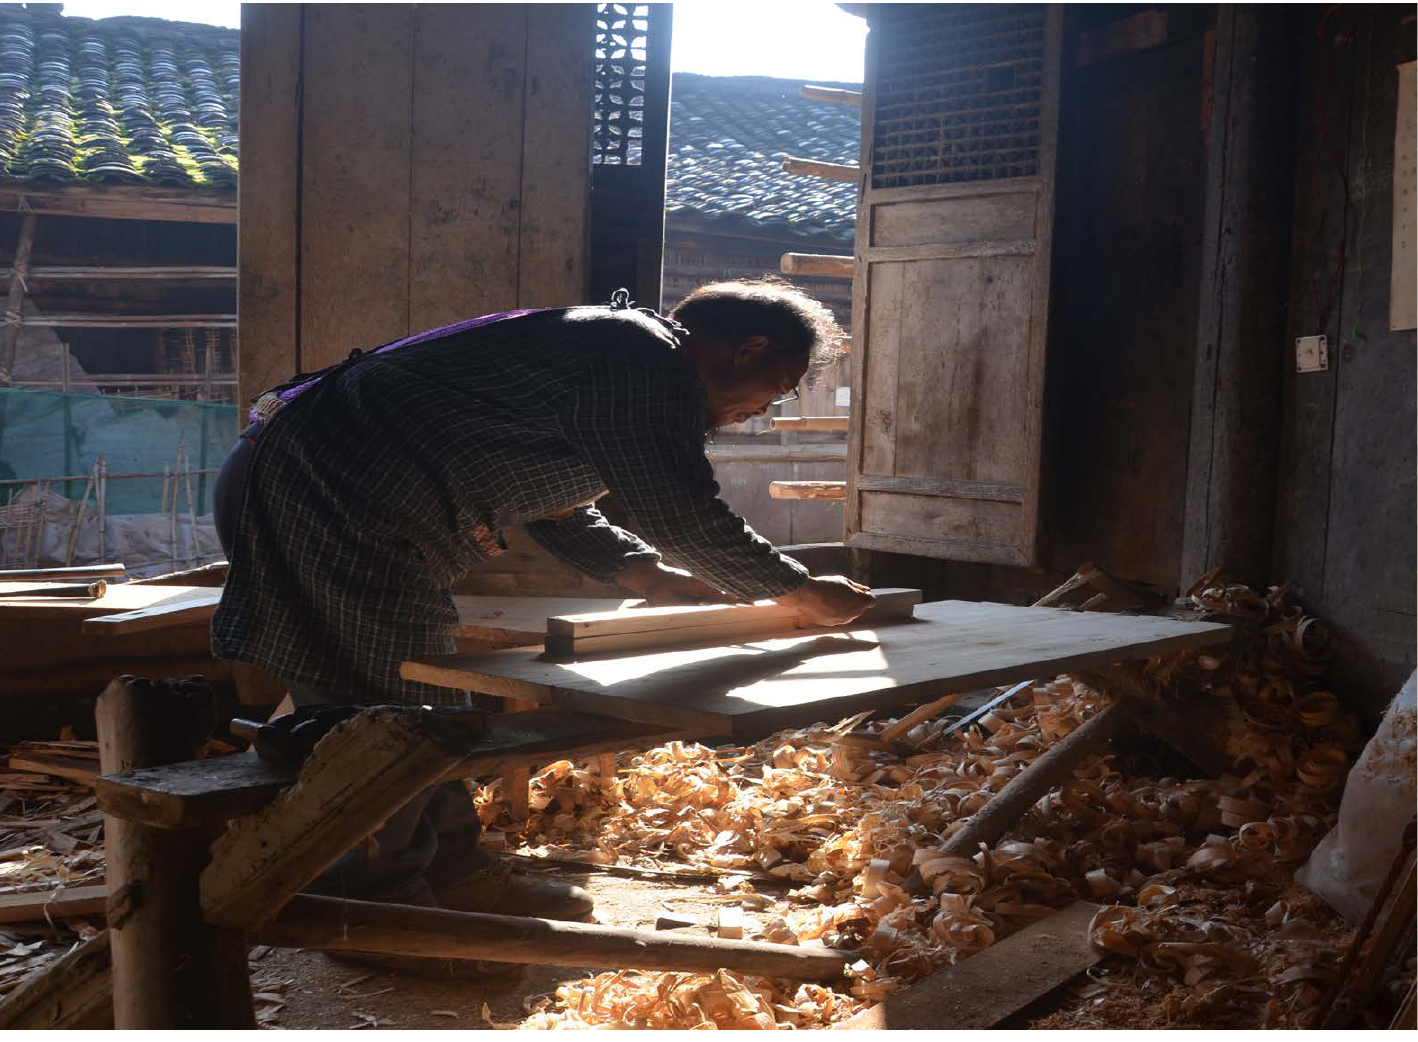
Figure 5 (page 158, top): Outdoor cinema screenings, Miaoxia , summer 2017. Source: Author. Figure 6 (page 158, bottom): Miaoxia community guesthouse construction process. Source: Author. Figure 7 (this page): Miaoxia community guesthouse carpentry work. Source: Author. Figure 8 (opposite): Miaoxia community guesthouse view of bathroom with library above. Source: